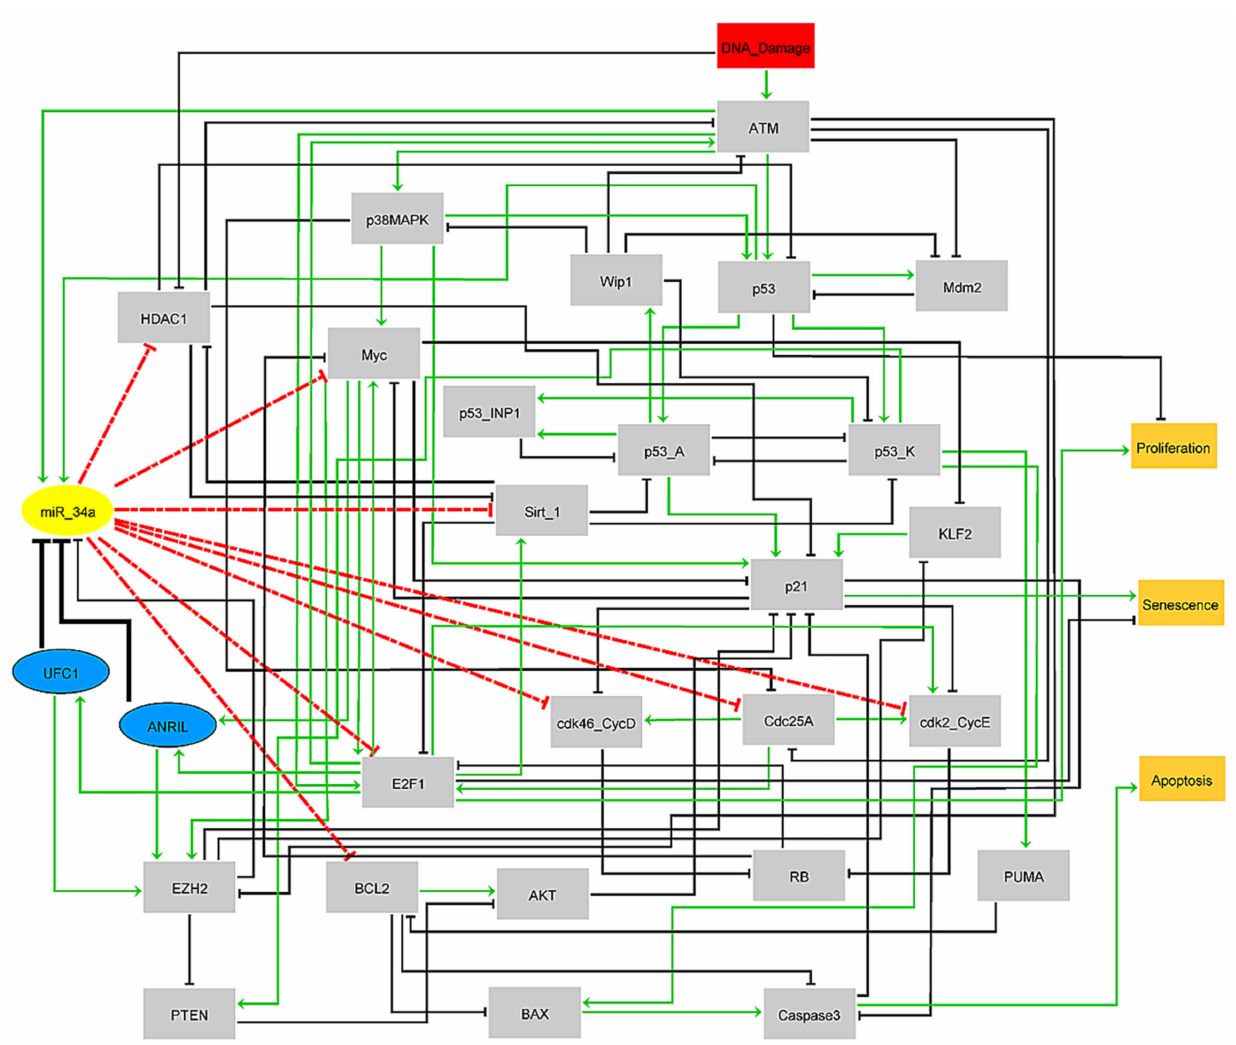
Figure 1. The gene regulatory network for the G1/S checkpoint in response to DNA damage. Arrows denote activations in green and hammer-head arcs represent inhibitions in black, respectively. Dashed hammer-head arcs in red represent targets of miR-34a. The yellow elliptic node represents miR-34a, whereas the blue elliptic nodes represent lncRNAs: ANRIL and UFC1, respectively. The input rectangular node in red denotes DNA Damage. The model outputs in orange in the rectangular nodes are Proliferation, Senescence, and Apoptosis,